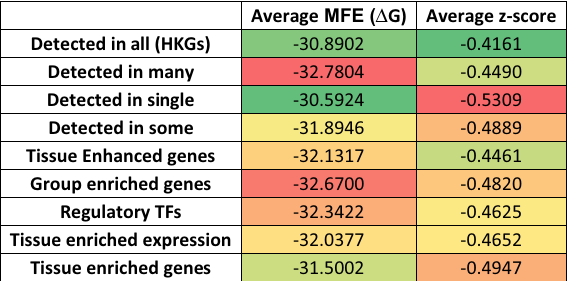
Table 1. Analysis of average windowed MFE and z-score for differentially expressed genes in the human